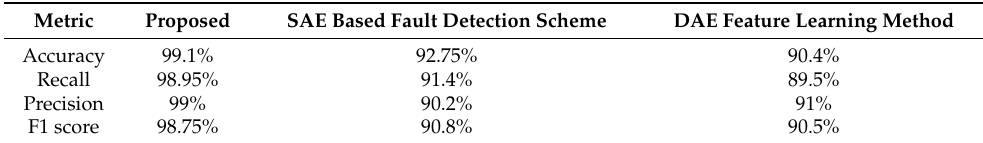
Figure 12. Confusion matrices (CM) of ( a ) the proposed method, ( b ) the DAE feature learning method, and ( c ) the SAE-based scheme for a 3.0 bar pressure vibration dataset. Table 3. Results obtained from the proposed and compared methods for 3.0 bar inlet pressure vibration data.